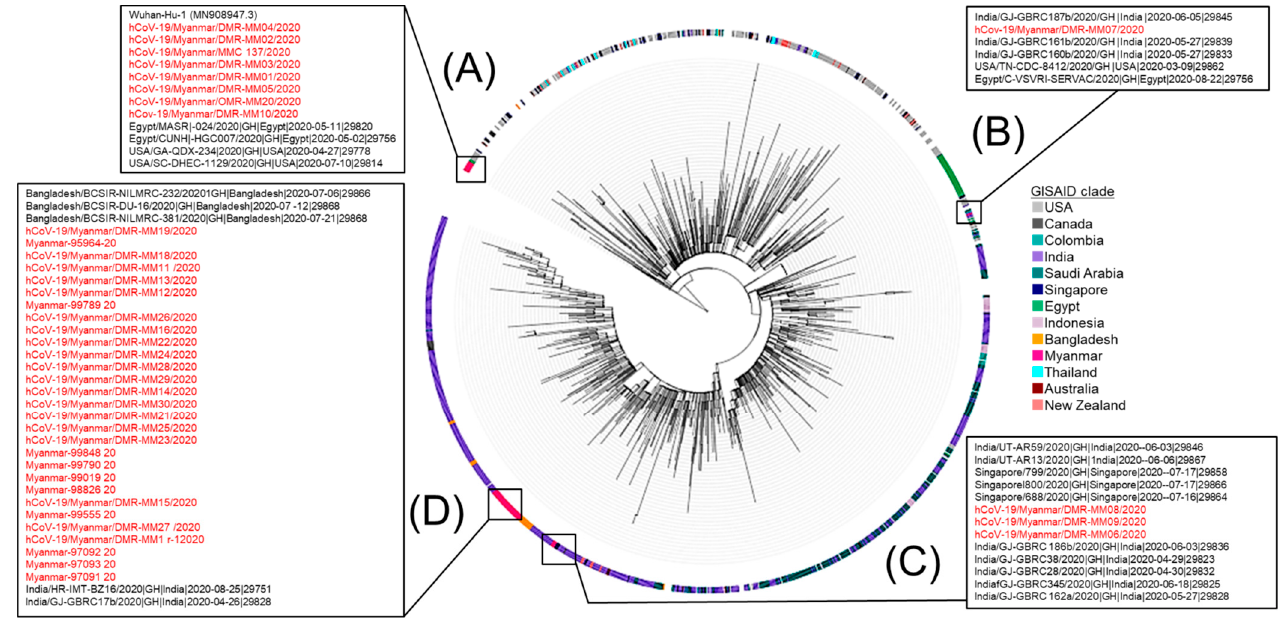
Figure 4. Phylogenetic tree of SARS-CoV-2 in Myanmar. Maximum-likelihood (ML) tree was created with 41 Myanmar strains, 509 global strains, and 770 strains in neighboring Asian countries collected from December 2019 to September 2020, downloaded from Global Initiative on Sharing All Influenza Data (GISIAD). Countries with more than 10 strains were used in the phylogenetic tree. The 41 strains from Myanmar are marked in pink, and different colors denote different countries. ( A ) Clade O, ( B ) Clade GR, ( C ) Clade GH, ( D ) Clade GH. Table 2. List of nucleotide substitutions found in 10 strains from Myanmar in this study, as compared with reference strain